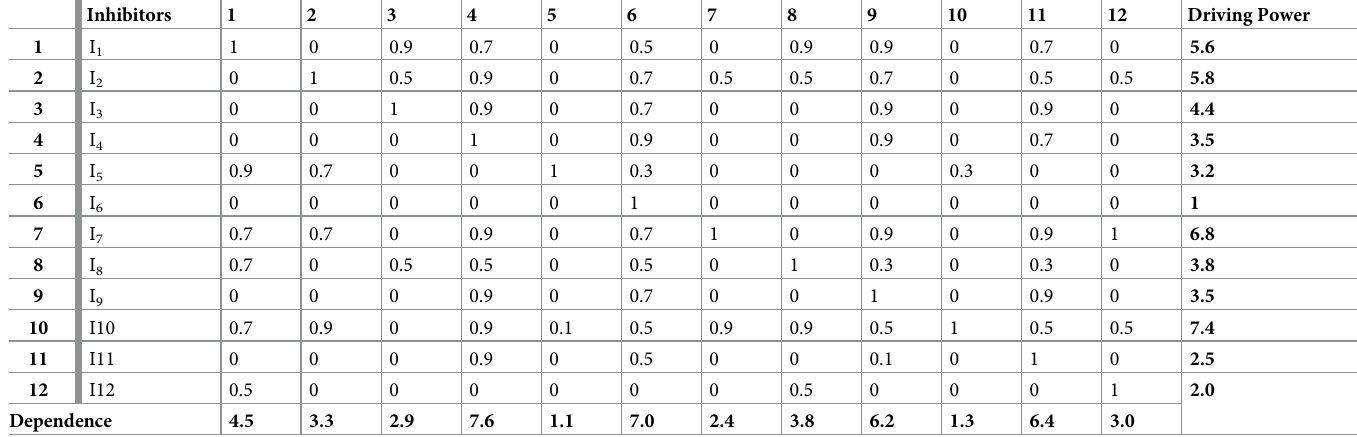
Table 6. Fuzzy direct reachability matrix (FDRM).